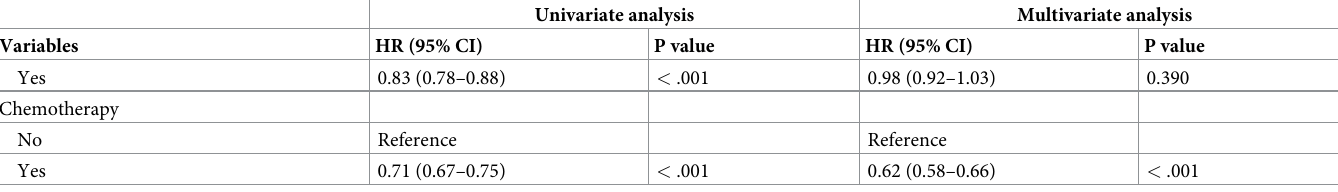
S1 Table. Univariate analysis and multivariate analysis for overall survival (OS) and cancer specific survival (CSS) among patients with metastatic breast